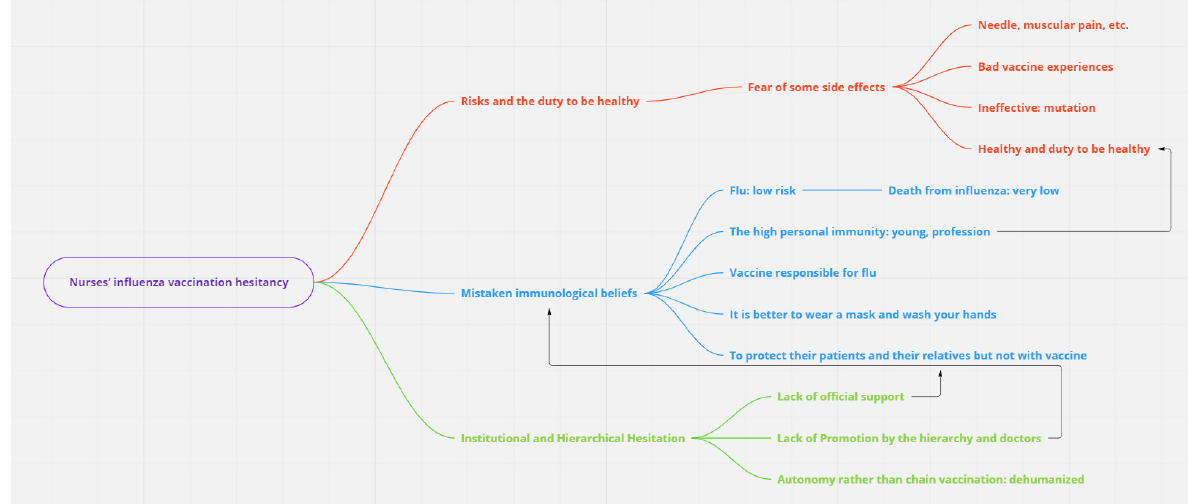
Figure 2. interactions among the determinants of VH. Figure 2. Interactions among the determinants of Risks associated with vaccines are common determinants to the VH caretakers and the VH parents [26]. This perception of risk to both VH parents and nurses can be based on a personal experience or that of close relatives [26]. In both populations (parents and nurses), the risk determinant is related to the benefits’ determinant. The perception of risk and benefit varies by location of work [27]. For example, a nurse who works in an inten- sive care unit in a teaching hospital may be able to care for a patient suffering from flu